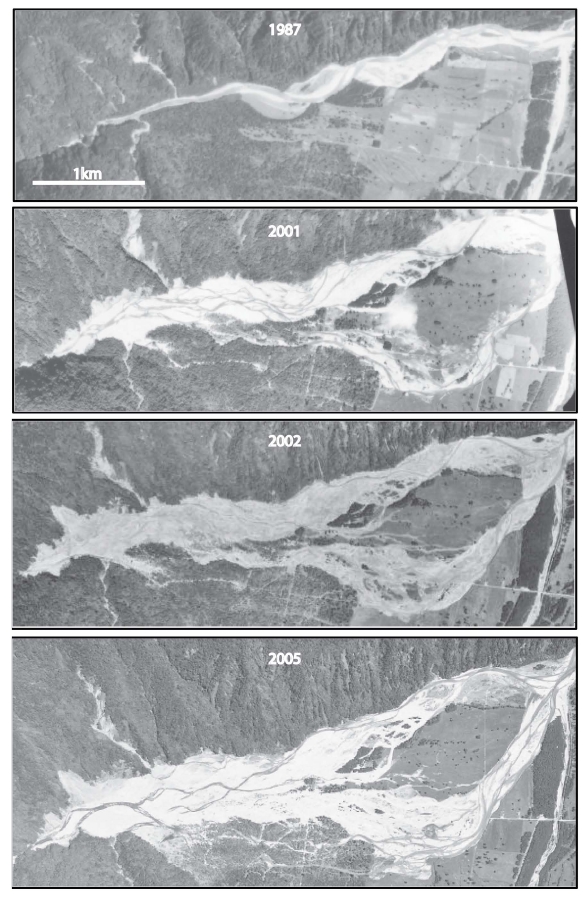
Fig. 8. Aerial photos of the Poerua River from 1987 to 2005 show- ing the change in channel flow and active aggradation across the alluvial fan. After Davies et al.